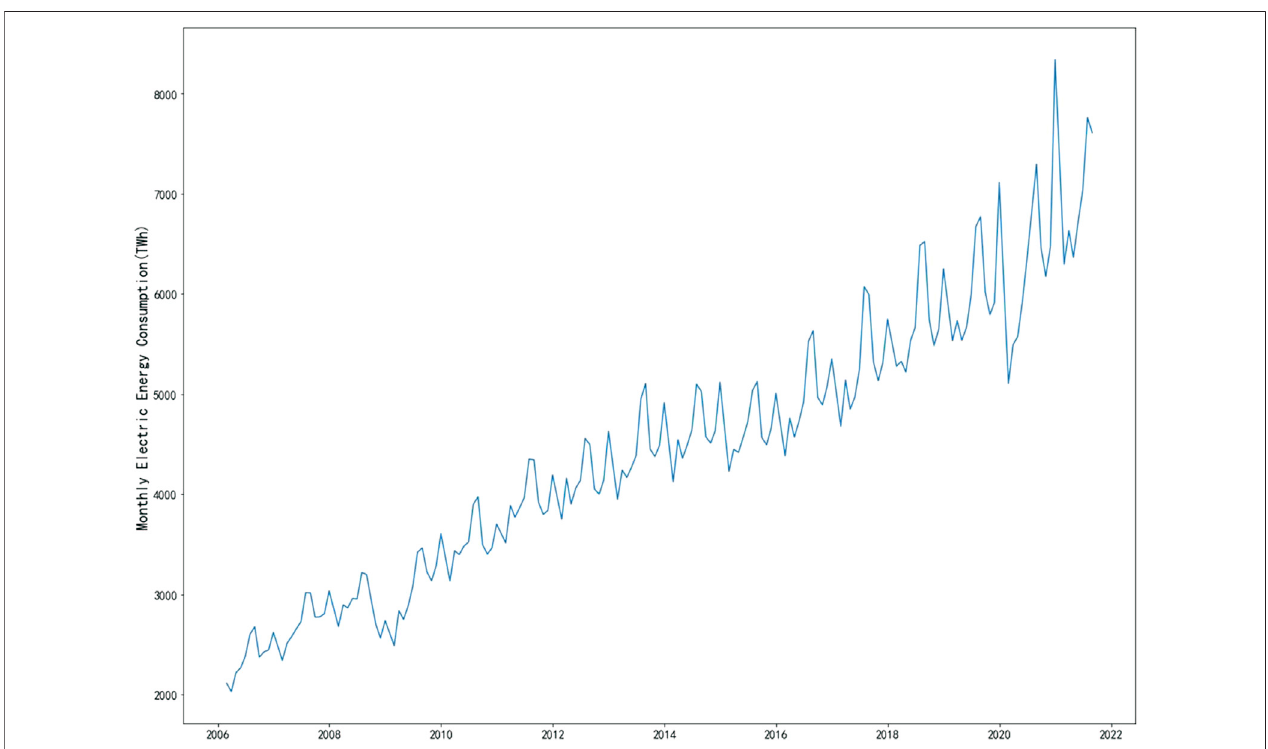
FIGURE 3 | The monthly electricity consumption of China from 1 and 2 2006 to August